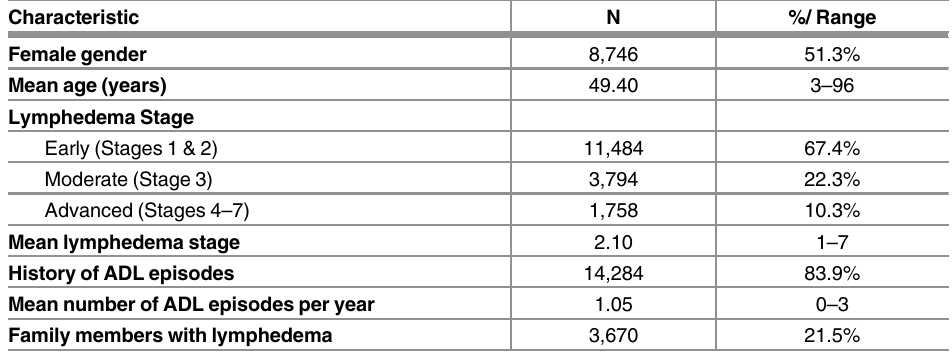
Table 1. Morbidity census demographics, Khurda District, Odisha State, India (N =